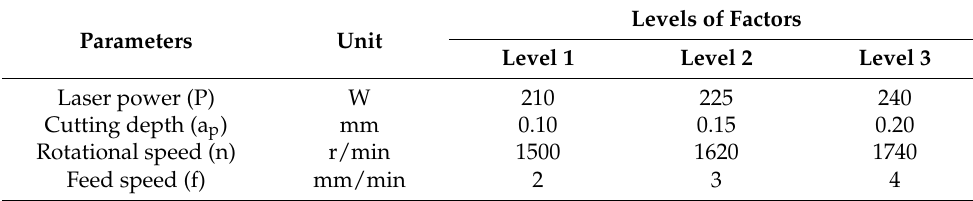
Table 2. Orthogonal experimental factor level.